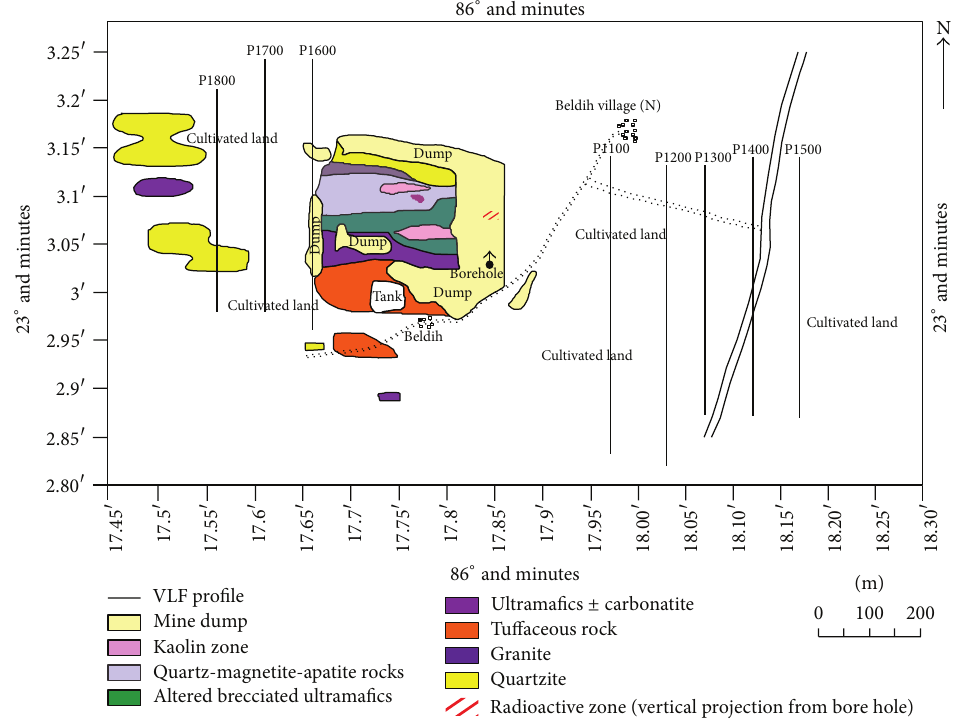
Figure 1: Geological map of Beldih mine (modified after [7]) showing VLF profiles (straight